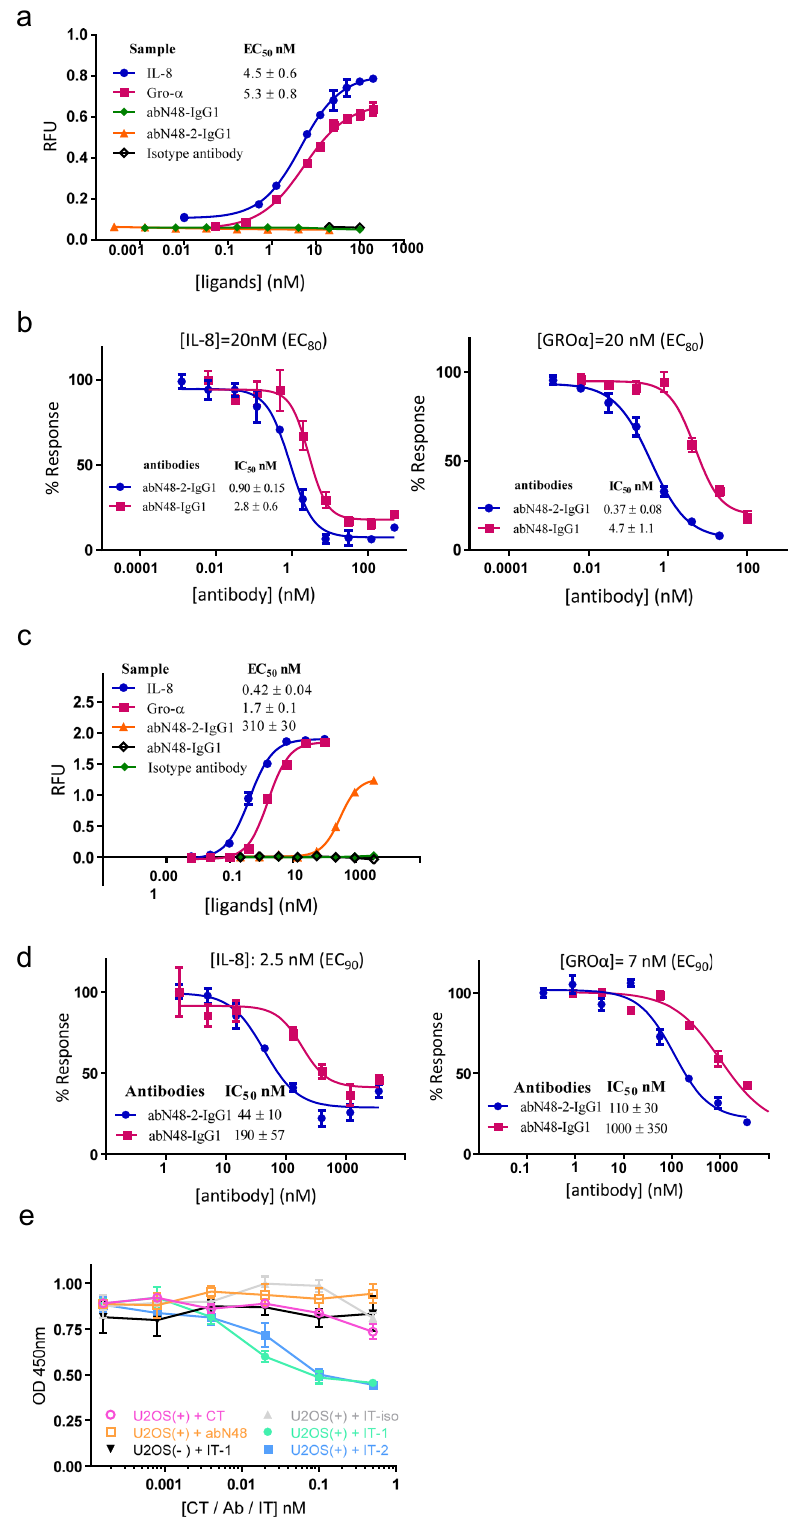
Potent induction of endocytosis of h CXCR2 . IL-8 also induces endocytosis signaling of CXCR2 at 5 – 10 nM 48 . To test any anti- body effect, internalization of CXCR2 was studied using U2OS cells overexpressing membrane-bound h CXCR2. Immunotoxin complexes of abN48-IgG1 or abN48-2-IgG1 with a cytotoxin